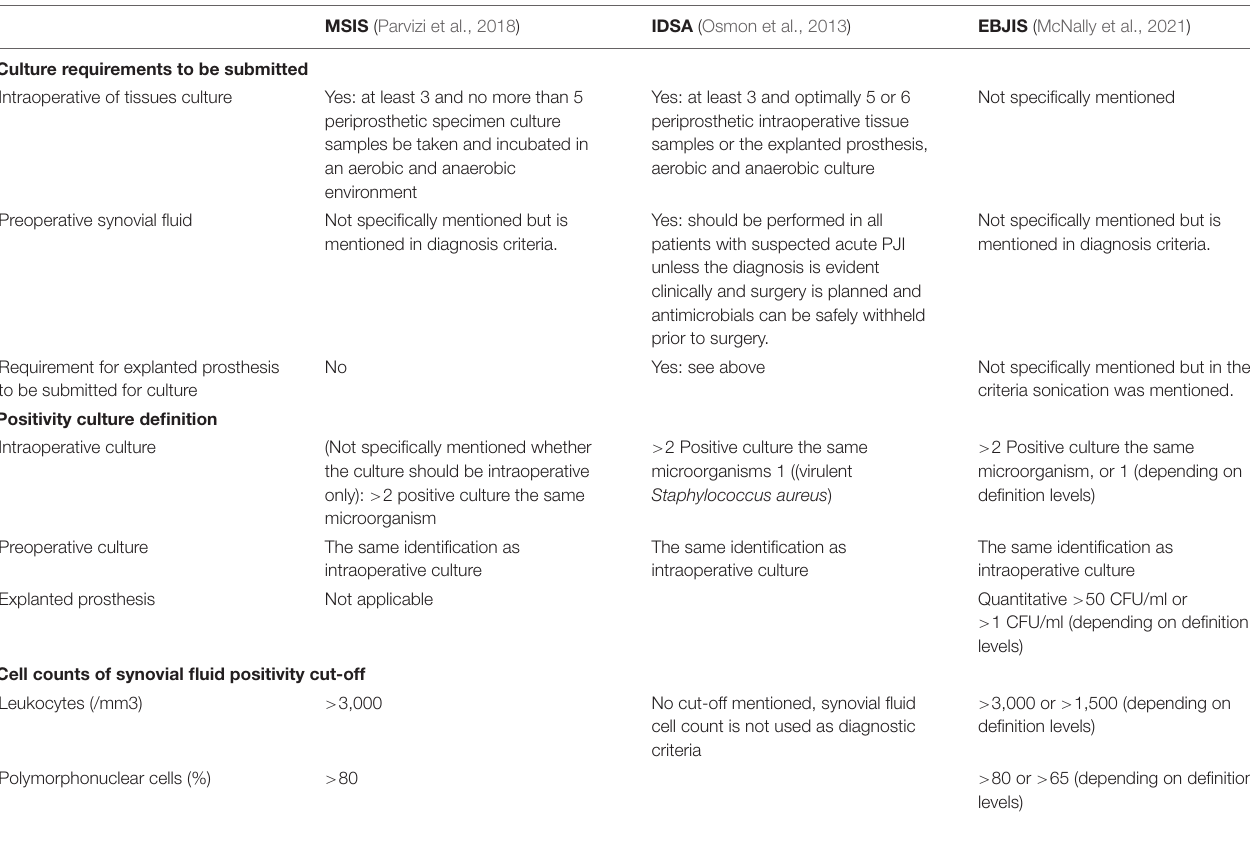
TABLE 5 | Clinical microbiology criteria according to various organizations. MSIS (Parvizi et al.,